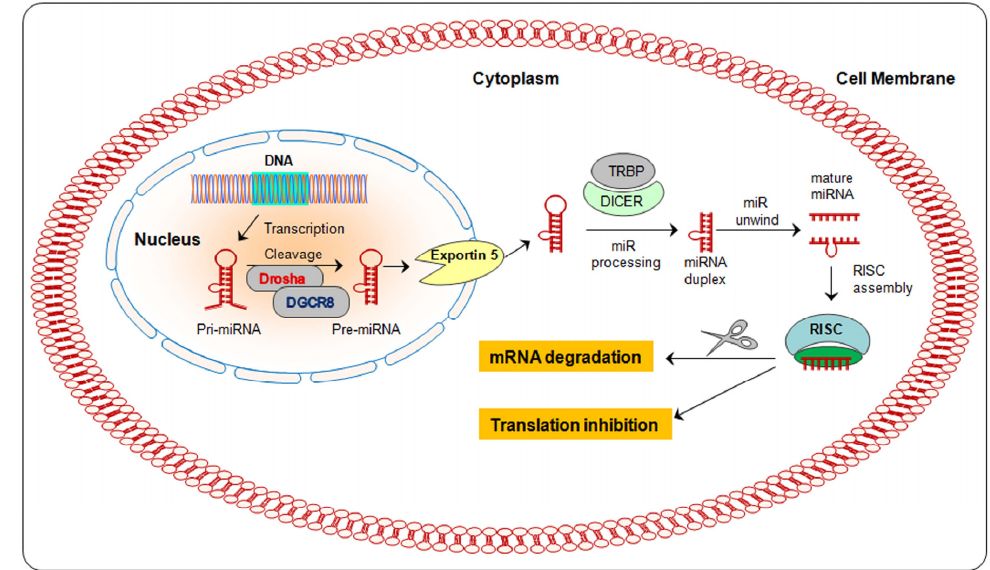
Figure 1. The biogenesis of miRNAs. MiRNAs are initially transcribed from introns or intergenic regions of DNA as long primary miRNA transcripts (pri-miRNA) and cleaved in pre-miRNAs smaller transcripts (~70 nucleotides long). After their export to the cytoplasm, pre-miRNAs are processed, unwind to mature miRNAs and loading into the RNA-induced silencing complex (RISC). This complex actively binds to mRNA targets and negatively regulates their gene expression and/or translational repression.